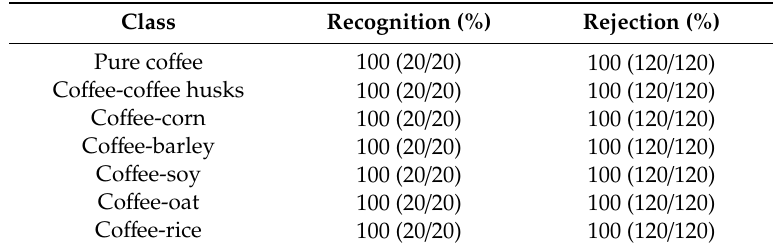
Table 2. Recognition (sensitivity) and rejection (selectivity) of the SIMCA model.